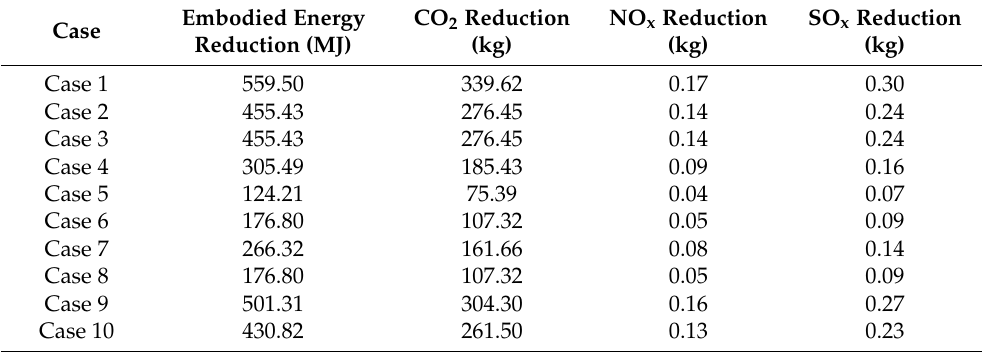
Table 7. Embodied energy reduction and reduction in pollutants by using different metal foam configurations inside the DAPTC at the flow rate of 120